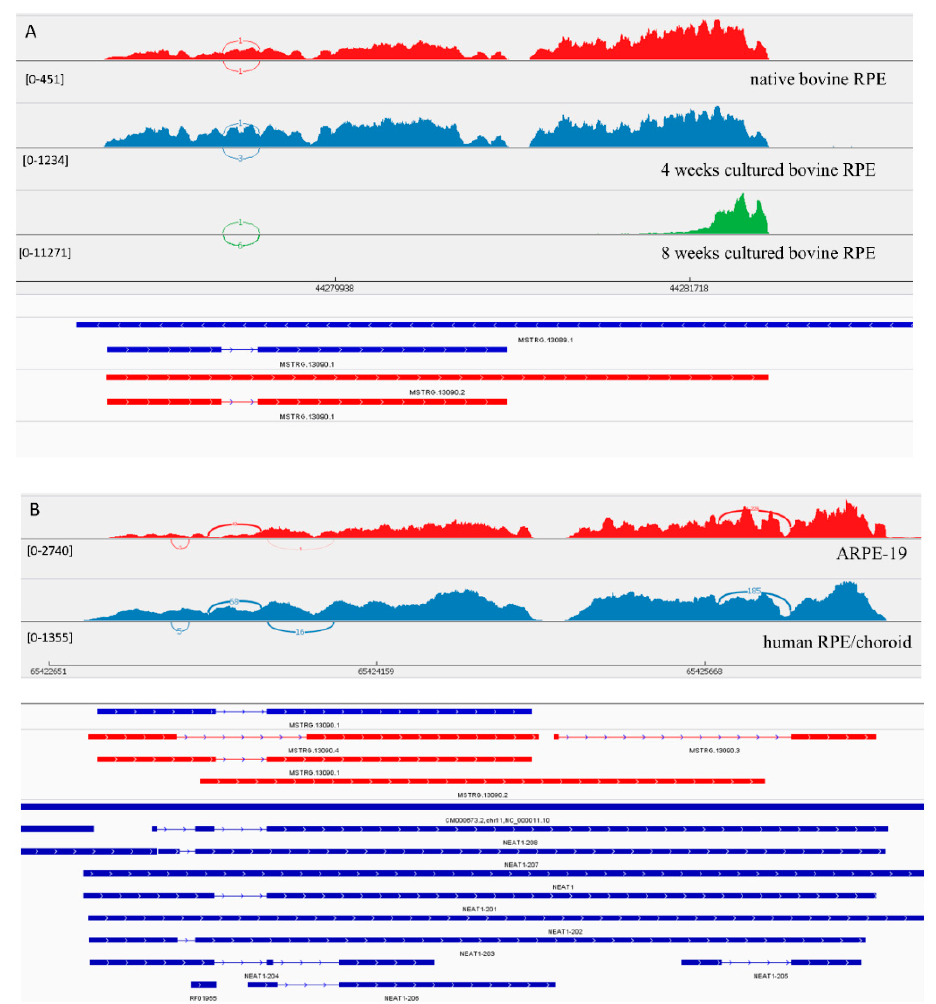
Figure 2. View of NEAT1 from the Integrated Genome Viewer (IGV). IGV–Sashimi plots showing the read coverage and transcript isoforms. The histograms represent the sum of the aligned sequencing reads along the genome. Numbers in square brackets indicate coverage range. Junction reads are plotted as arcs, and the number of reads aligned to the junction spanning the exons connected by the arc is indicated. ( A ) Sashimi plots from bovine genome; red histogram represents the coverage for native bovine RPE, blue is 4-week cultured bovine RPE, and green is 8 weeks cultured bovine RPE. Below the histograms are shown the predicted isoforms (blue), experimentally verified in this study (red). ( B ) Sashimi plots from human genome; red histogram represents coverage for ARPE-19 cells and blue represents the native human RPE/choroid. Below the histograms are shown the predicted isoforms (blue), experimentally verified in this study (red), and Ensembl genome browser isoforms (blue).